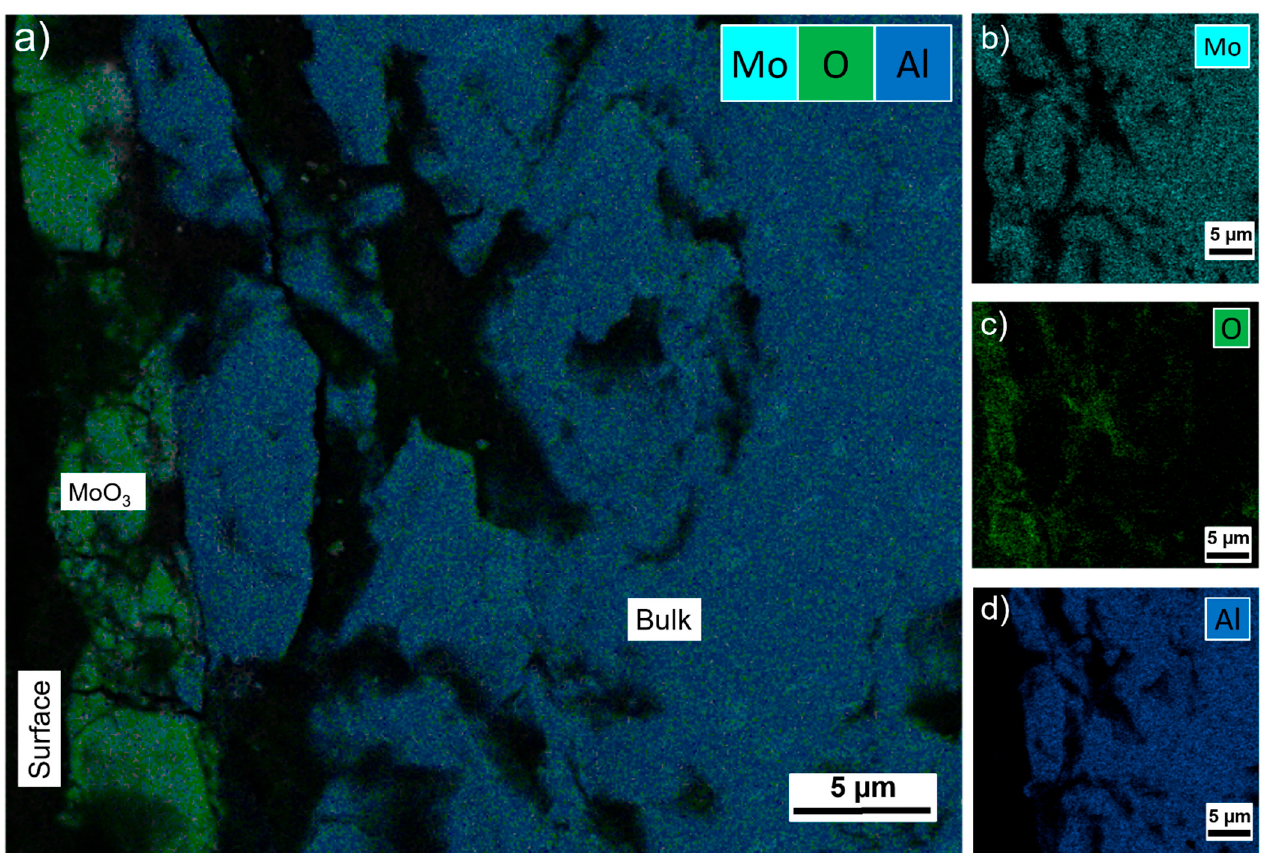
Figure 6. EDS analysis of SS_HF: ( a ) layered compositional map depicting Mo, O and Al content; ( b ) Mo elemental map; ( c ) O elemental map; and ( d ) Al elemental map.